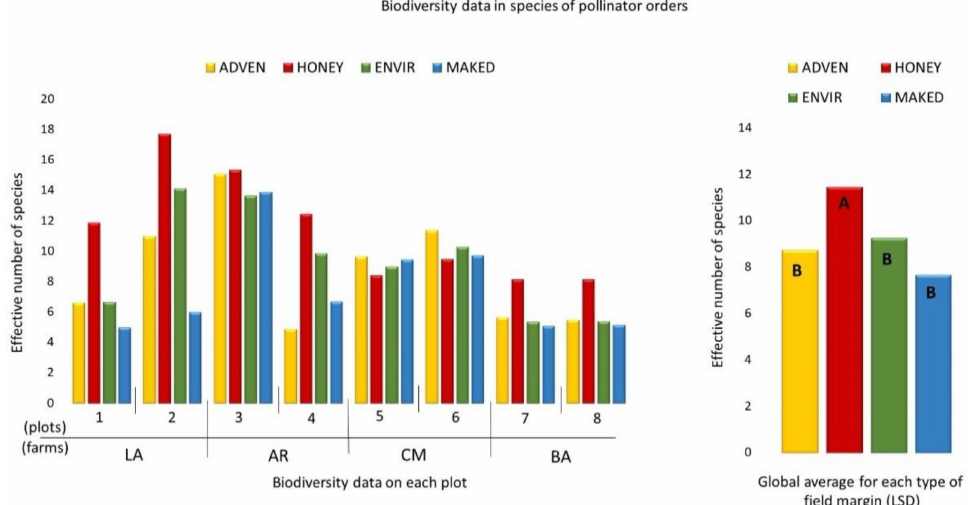
Figure 5. Biodiversity of the arthropods captured on the flora of the margins, on each farm and on a general scale. Different letters (A, B, C) show significant differences in the analysis of variance obtained in the different margins through the LSD test ( p ≤